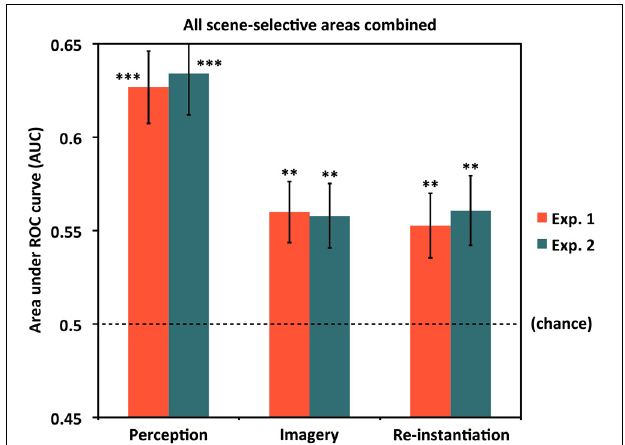
FIGURE 2 | Classification across all scene areas. Classification accuracy for Experiments 1 and 2 using voxels from all scene-selective ROIs. Analyses used 640 voxels per participant (4 scene-selective regions × 2 hemispheres × 80 voxels per region). Results are shown for classifying between individual scene items during perception (left bars), classifying between scenes during mental imagery (middle bars), and re-instantiation of perceptual information during mental imagery (right bars). All were significantly above chance (AUC = 0.5) for both experiments. ∗∗ p < 0 . 01, ∗∗∗ p < 0 . 001. Error bars represent standard error of the mean (s.e.m.). See text and Table 1 for full